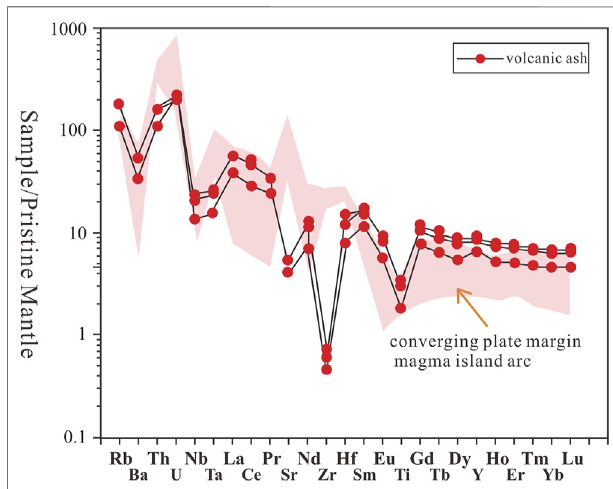
FIGURE5| Spider diagramafter mantle normalization oftheelementsin volcanic ash in the Lengshuixi section of the Maokou Formation. Convergent plate marginal magmatic island arc data are taken from Huang et al., 2018).